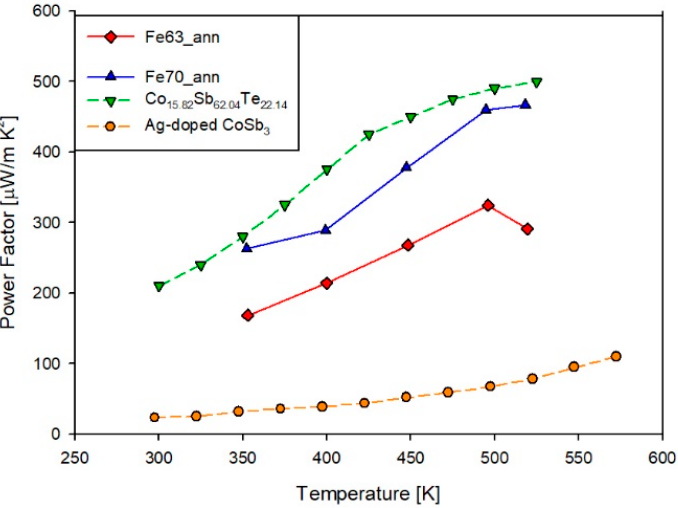
Figure 12. Trend of the power factor as a function of temperature for samples Fe63_ann and Fe70_ann compared to other samples in literature, namely Co 15.82 Sb 62.04 Te 22.14 [37] and Ag-doped CoSb 3 [48].